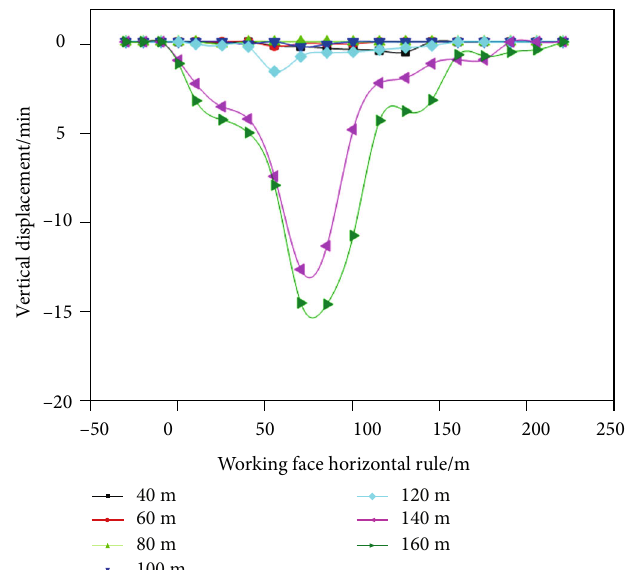
Figure 5: Dynamic subsidence curve of No. 1 line in the process of 600m deep mining depth.